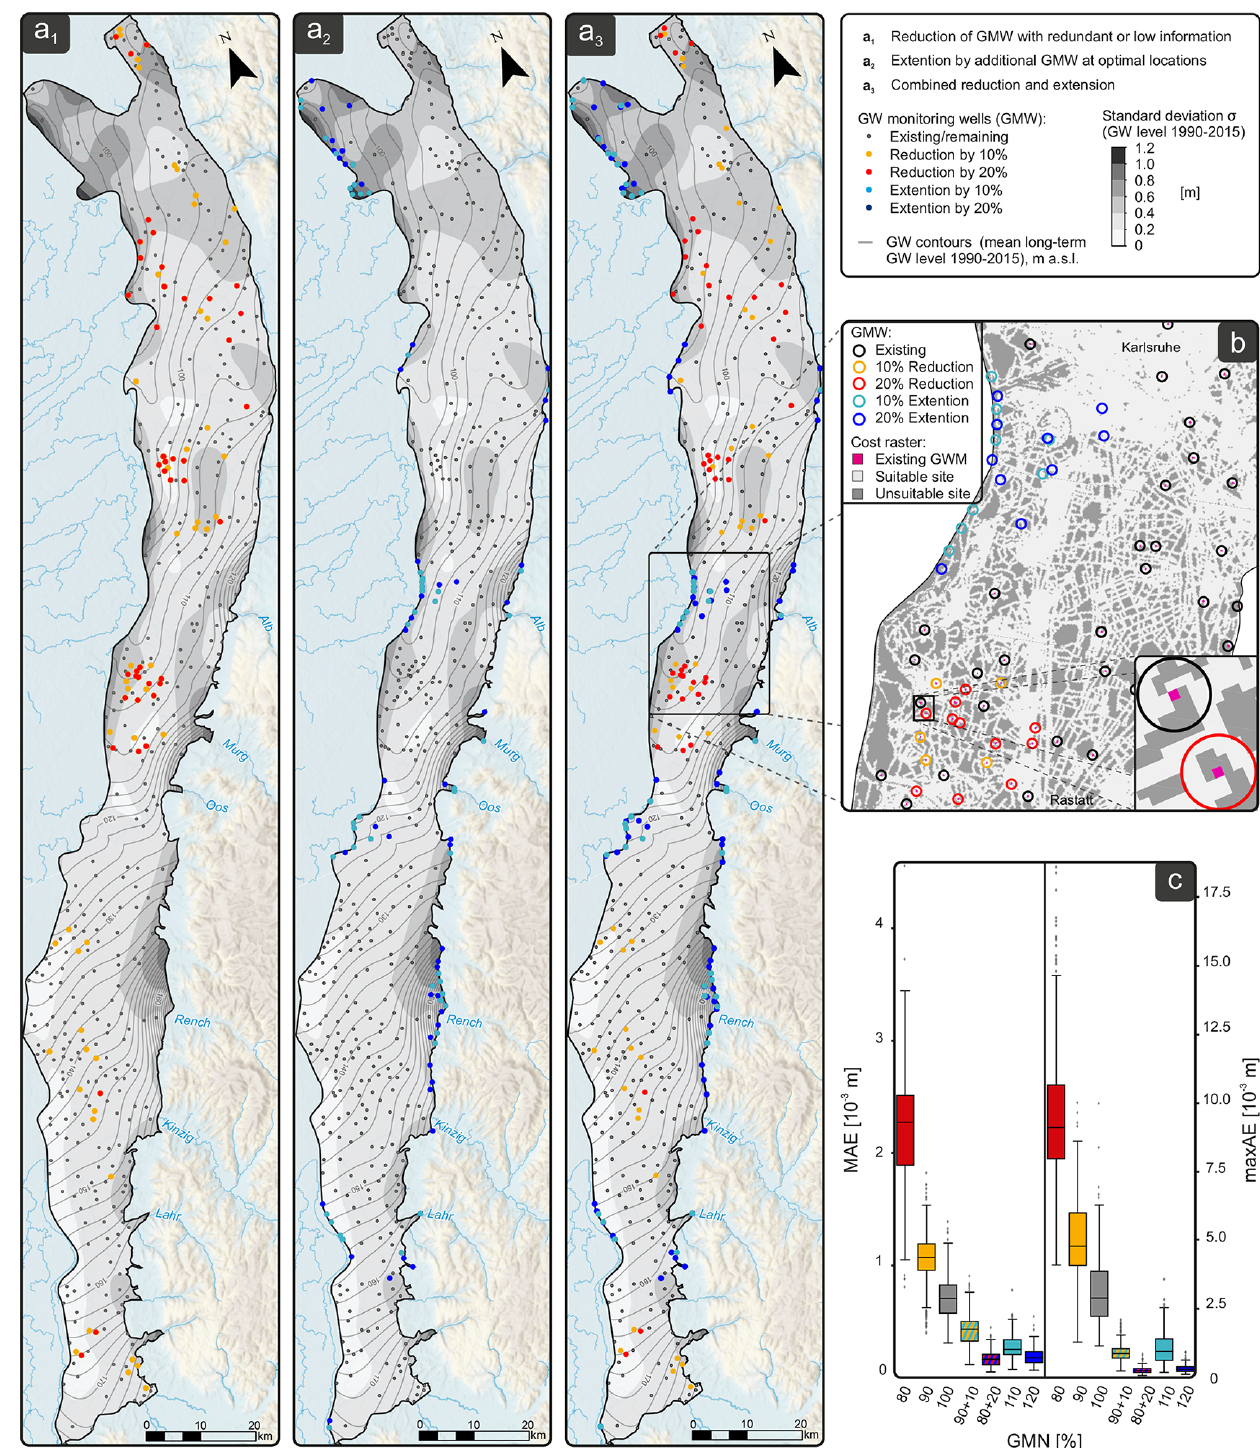
Figure 7. (a) Location of removed groundwater monitoring wells (GMWs) in a 10% (yellow) and 20% (red) QR-based monitoring well reduction (left map; panel a 1 ), in a 10% (light blue) and 20% extension (center map, a 2 ), and in a combined reduction/extension in which 10% and 20%, respectively, of the monitoring wells were removed and replaced with wells at optimal locations (right map; panel a 3 ). (b) Cost function grid used for the GMN extension. (c) Box plots show the mean and maximum absolute error of the reconstruction of the 216 GWL contour maps of the test set obtained with the mentioned GMN